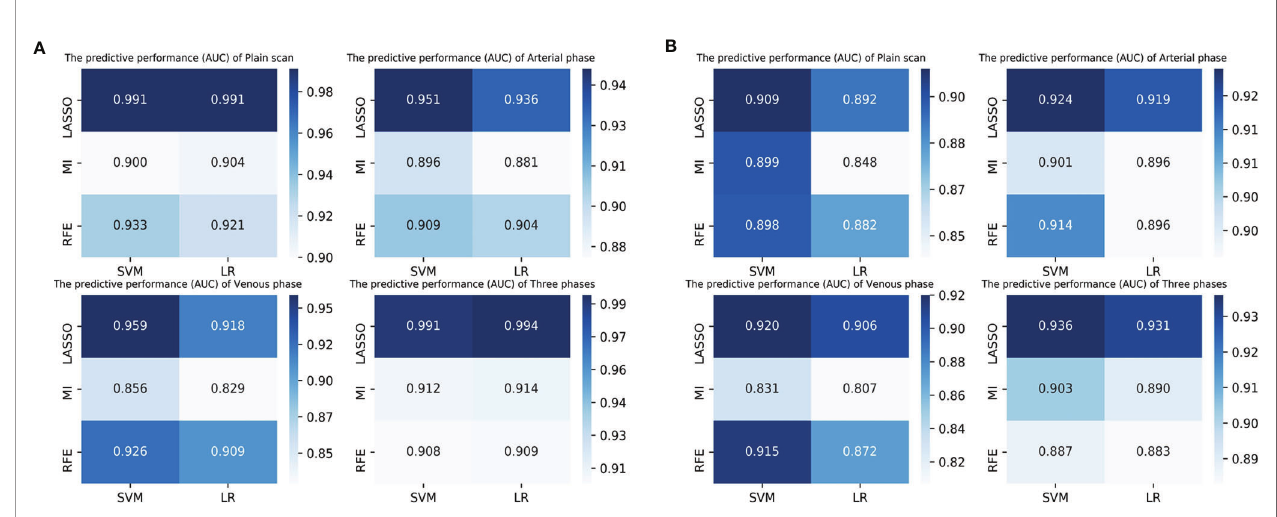
FIGURE 4 | The predictive performance (AUC) of radiomics models (3 feature selection methods and 2 classi fi ers) based on different phases in the training set (A) and test set (B) . LASSO, least absolute shrinkage and selection operator; MI, mutual information; RFE, recursive feature elimination; SVM, support vector machine; LR, logistic